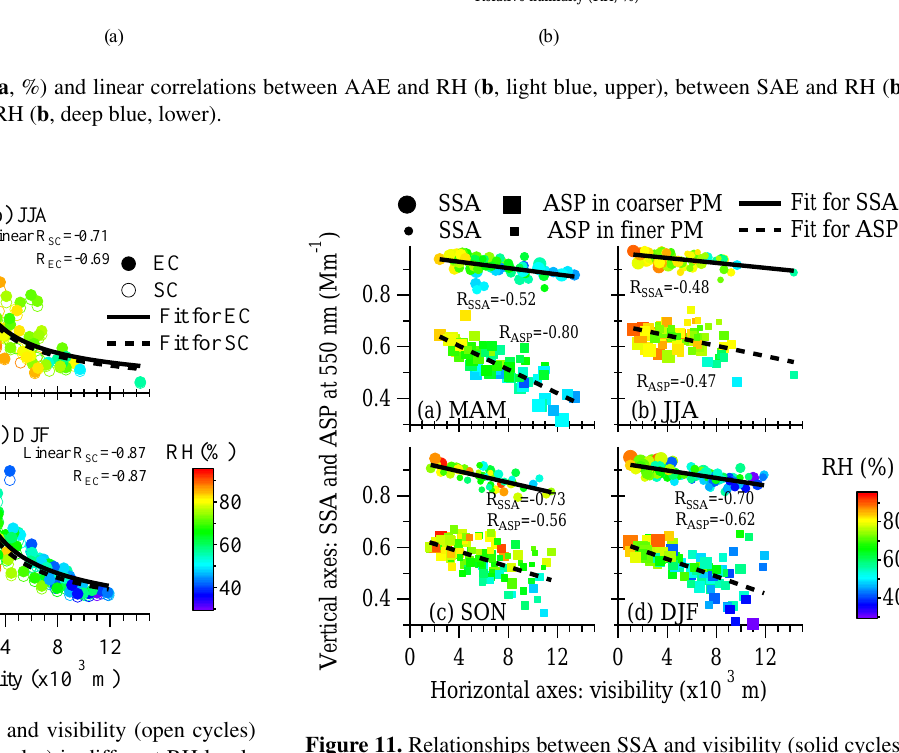
transported dust (or polluted dust) in spring and be influenced to some extent by biomass burning in